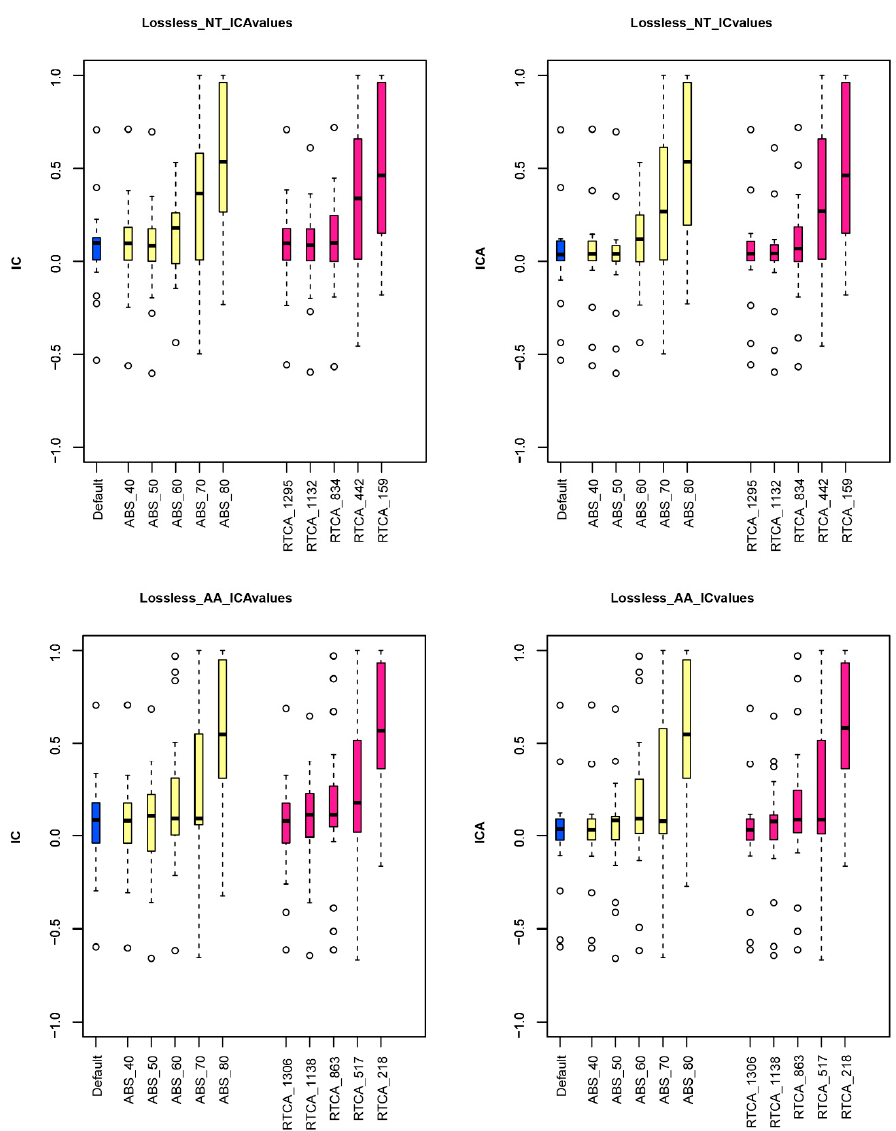
Figure 3. The changes of internode certainty (IC) values as well as internode certainty including all conflicting bipartitions (ICA) values of nucleotide (NT) as well as amino acid (AA). Blue represents the default analysis, yellow represents using genes with different average bootstrap support (ABS), and pink represents using genes with different relative tree certainty including all conflicting bipartitions (RTCA). The filter increases from left to right in every color.